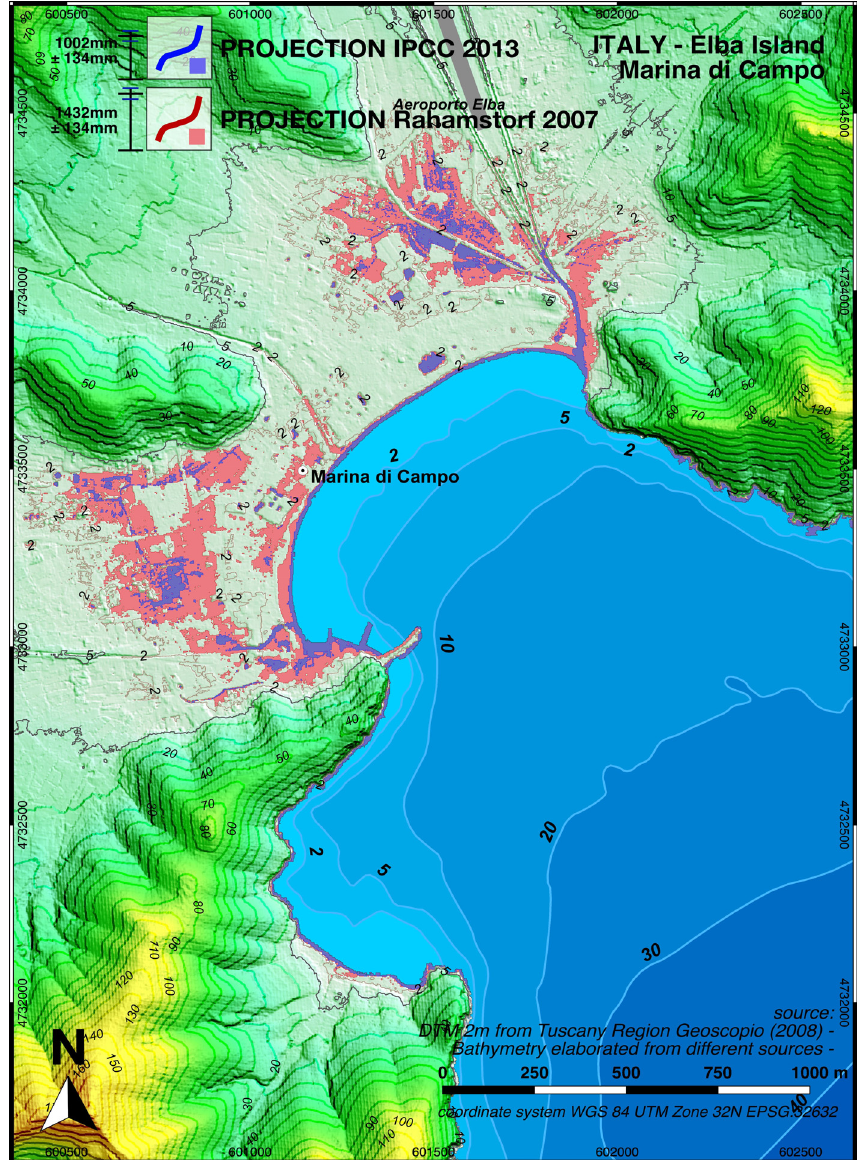
Figure 4. Map 5 Marina di Campo (Elba Island, Italy, see also Figure 1 for location). The potential submersion area, using Rahmstorf 2007 projections are 3.4 km 2